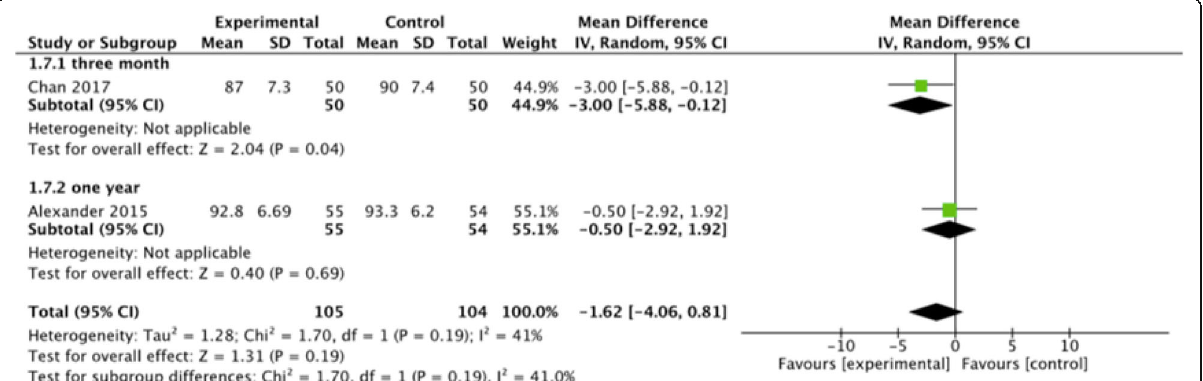
Fig. 8 Meta-analysis of barbed versus conventional suture based on Functional Scoring System. There was no significant correlation (OR -1.62